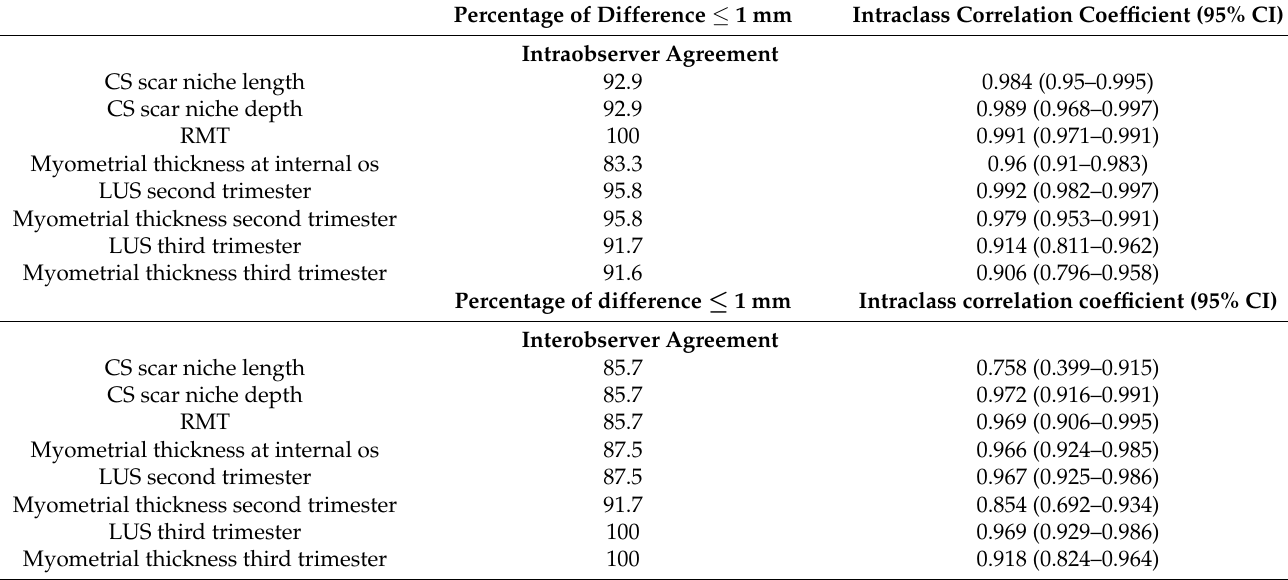
Table 4. Intraobserver (obtained by one researcher, with a short interval between measurements) and interobserver agreement for CS scar niche measurements and RMT in the first trimester, LUS and myometrial thickness in the second and third trimesters ( n =